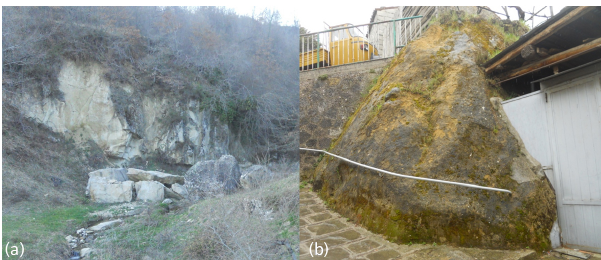
Figure 4. Outcrops of the Gorgoglione Flysch pelitic-arenaceous sequence at the confluence between Scannamogliera and Notar- mario streams (a) and in the village of Montemurro (b) , where sev- eral buildings rest upon massive sandstones.